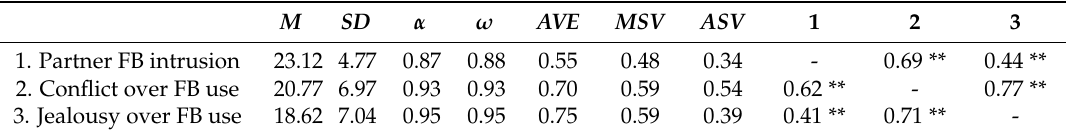
Table 5. Means, standard deviations, alphas, omega coefficient, average variance extracted, and